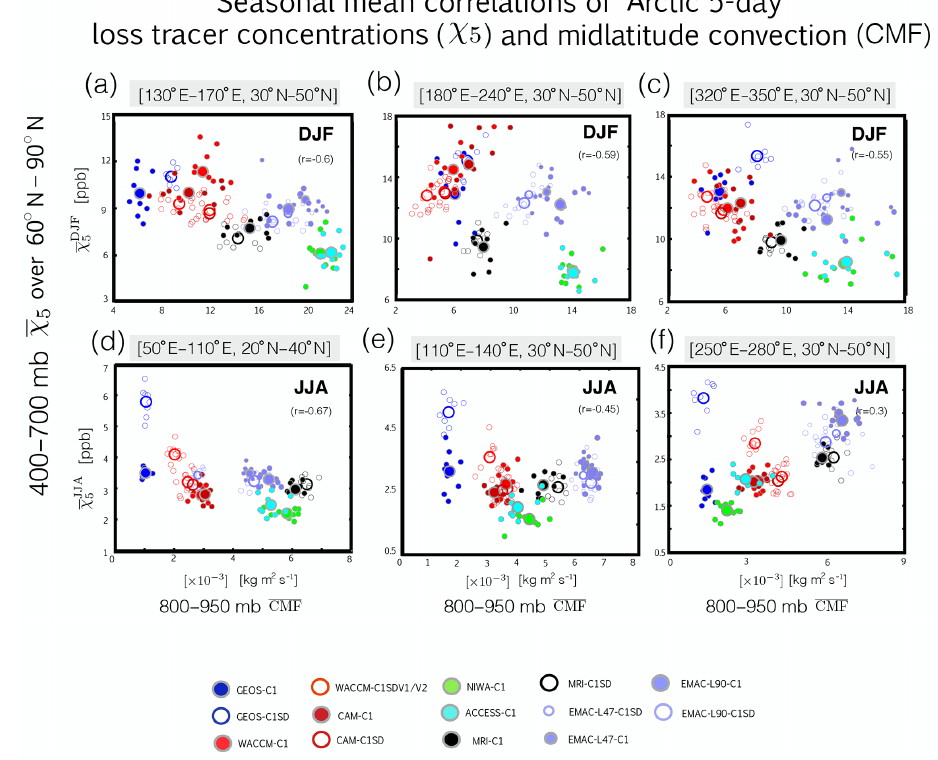
Figure 8. Scatterplots showing negative correlations between the strength of parameterized convection in the midlatitude lower troposphere, represented by the 800–950hPa averaged convective mass flux (CMF), and mid-tropospheric (400–700hPa) concentrations of the 5-day idealized loss tracer averaged poleward of 60 ◦ N. The convection regions coincide with the black boxed regions shown in Fig. 6. The different colors correspond to the different simulations, with open circles denoting REF-C1SD simulations and closed circles corresponding to REF-C1 (grey outline) simulations. Small circles correspond to individual years within the 2000–2009 climatological mean period, while large circles denote the climatological